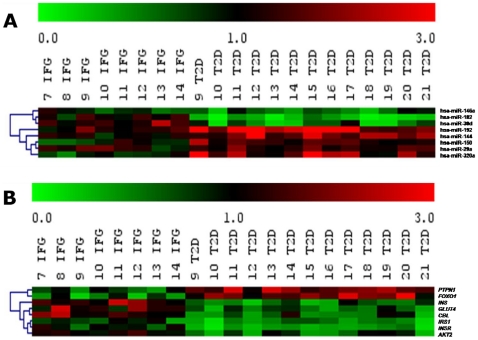
Comparison of miRNA expressions with its corresponding predicted mRNA targets (Batch B).
A
. A heatmap of quantitative stem-loop RT-PCR of eight selected miRNAs and 
B
. A heatmap of real-time PCR of respective predicted mRNA targets. Validation has been done in another independent batch (Batch B) of participants in triplicates. Statistically significant differences are tested at p<0.05 significance. Batch B patients consists of eight IFG patients (labeled as 7 IFG to 14 IFG) and thirteen T2D patients (labeled as 9 T2D to 21 T2D).CTL, healthy controls; IFG, impaired fasting glucose; T2D, type 2 diabetes. Green: down-regulation; Red: up-regulation; Grey: not detected. Predictions: miR-144/IRS1; miR-146a/PTPN1; miR-150/GLUT4 and CBL; miR-182/FOXO1; miR-192/INSR; miR-30d/INS; miR-29a and miR-320/AKT2.